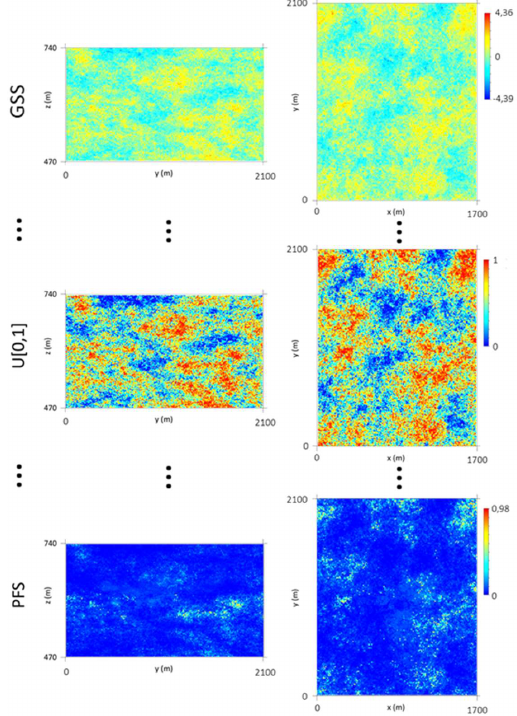
Figure 14. Probability Field Simulation (PFS) procedure: Gaussian Sequential Simulation (GSS) U [0, 1] transformation; and PFS simulation. The diagrams show 1 of 1000 scenarios.